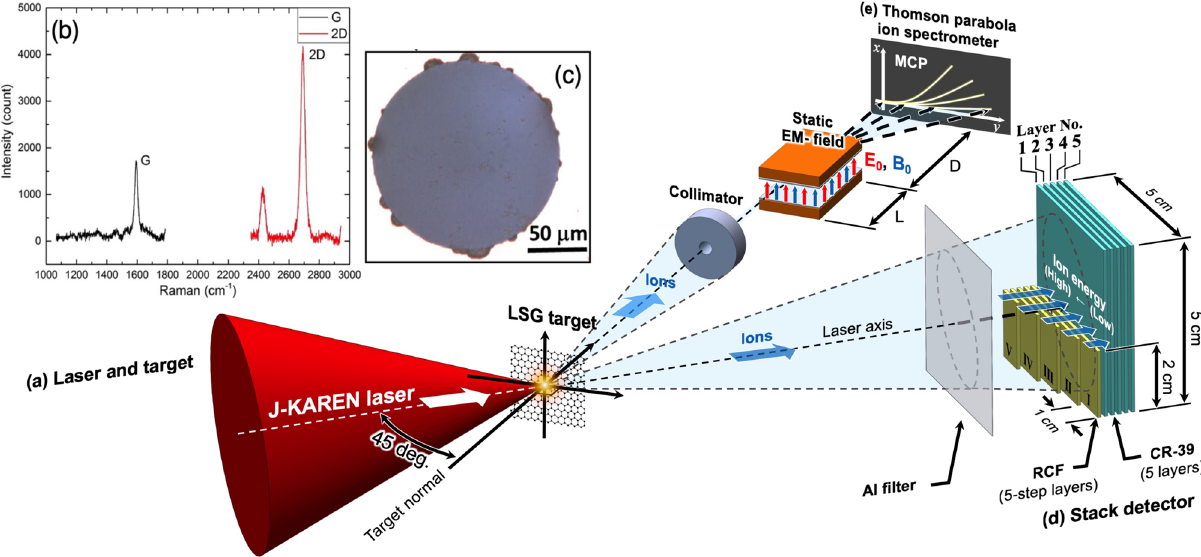
Figure 1. ( a ) Schematic setup of the experiment with the large-area suspended graphene target (LSG). ( b , c ) The Raman spectrum and the optical microscope image for a typical LSG, respectively. The accelerated ions are detected with: ( d ) a stack of radiochromic films (RCFs) and solid state nuclear track detector (CR-39) and ( e ) Thomson parabola